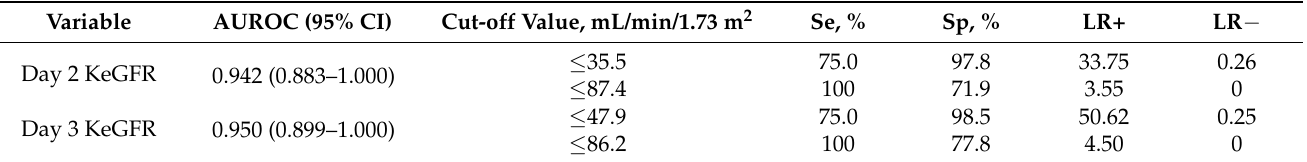
Table 4. Diagnostic accuracy of day 2 and day 3 KeGFR in diagnosis of renal failure defined according to the modified Marshall scoring